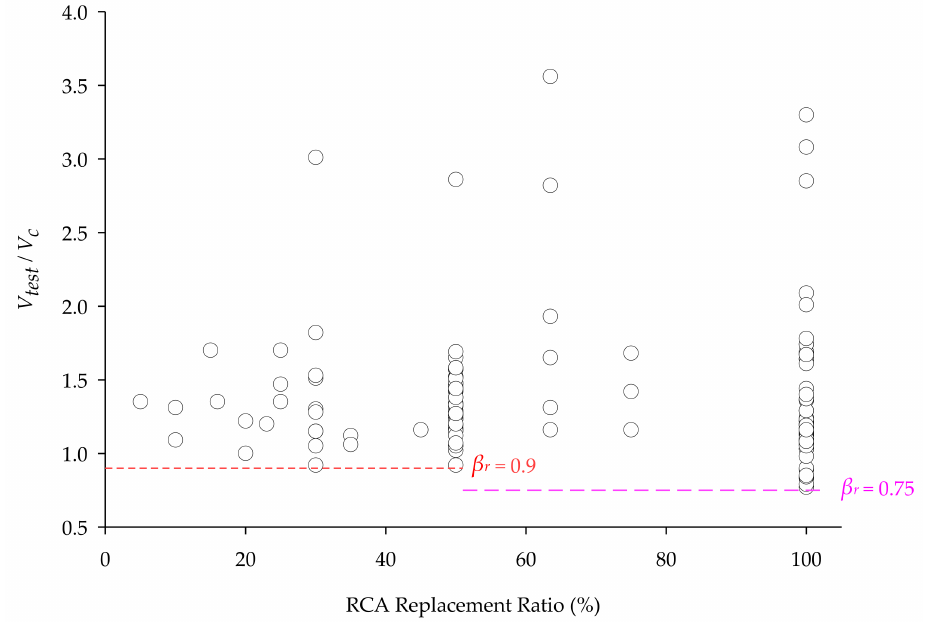
Figure 12. The proposed reduction factor for RCA to shear strength predicted by ACI 318-19 shear